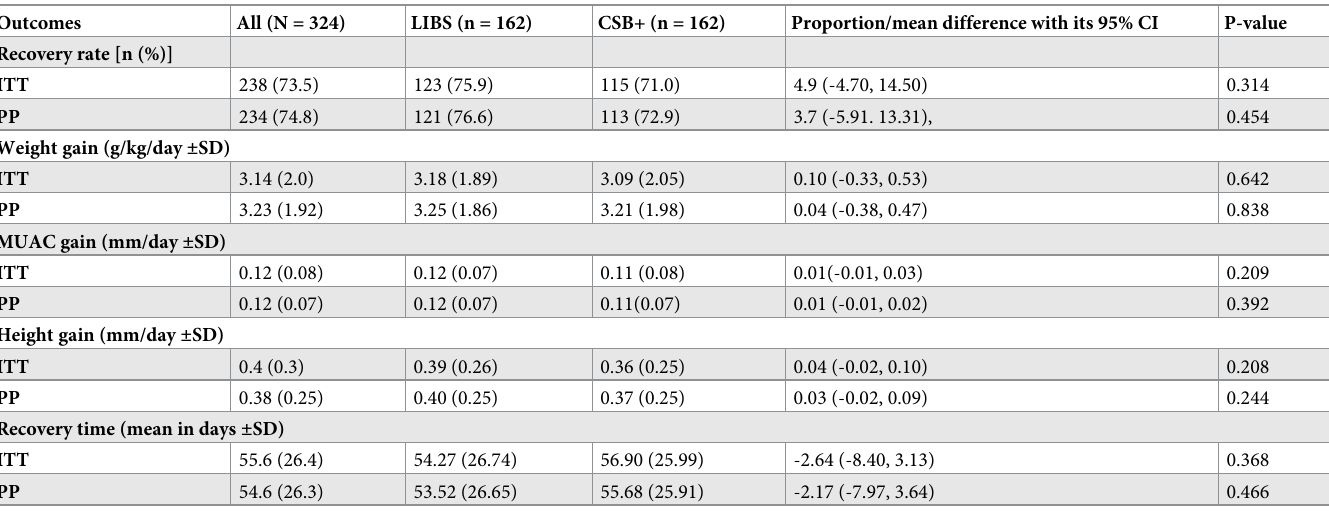
Table 3. Outcomes in the two intervention arms over 12 weeks.